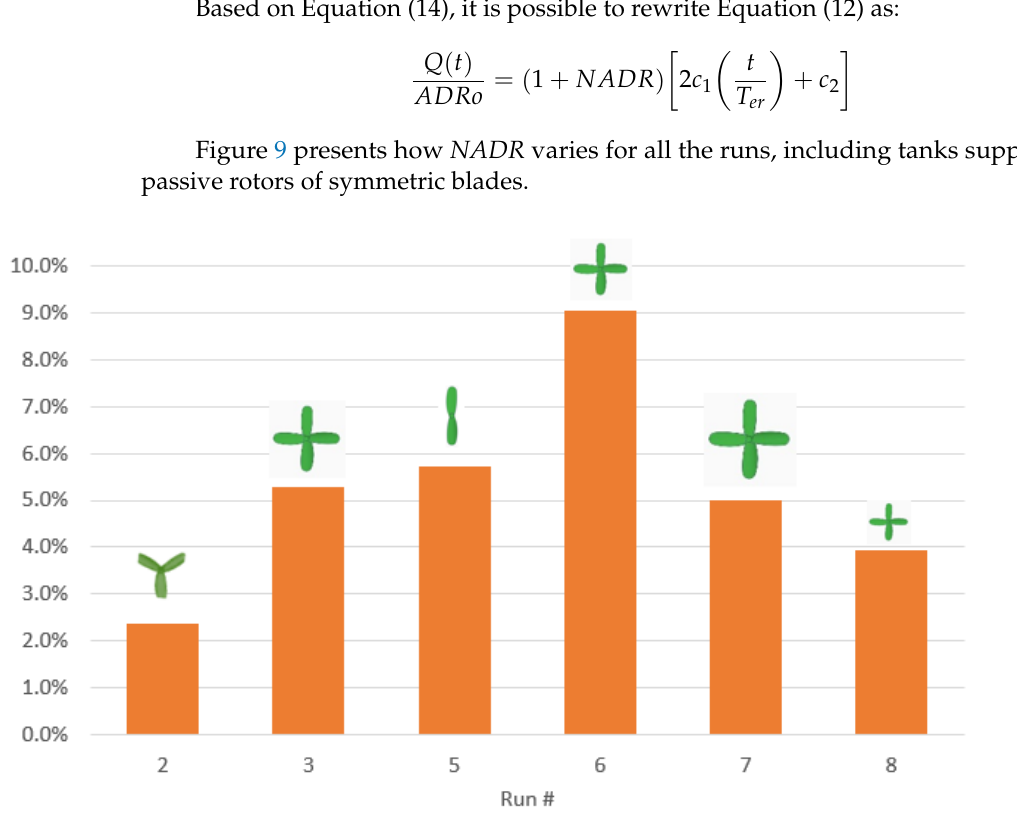
Figure 9. Effect of using passive rotors with symmetric blades on average tank drainage rate.